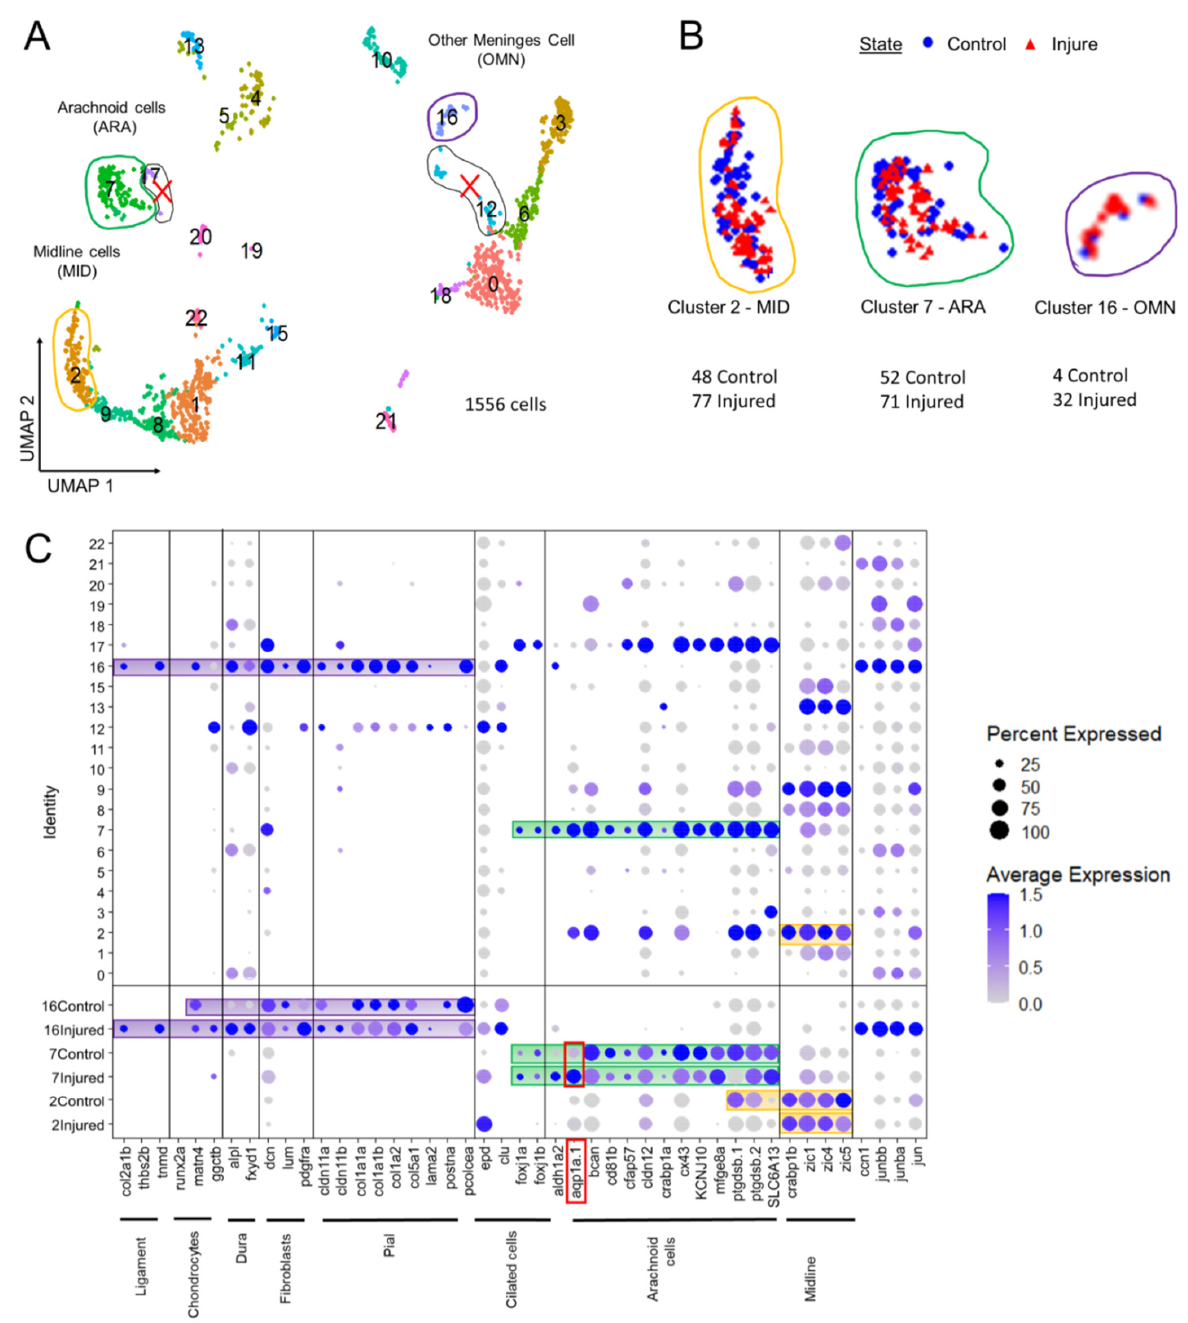
Figure 5. Analysis of scRNAseq data highlight cell heterogeneity of GFP cells from dissected tectum of PDGFR β -gal4;UAS: EGFP in 21 dpf injured fish and 21 dpf control fish. ( A ). Uniform manifold approximation and projection (UMAP) showing cell populations from 21 dpf control and injured fish. The projection was computed from the twenty first principal component analyses of gene expressions. Each point represents a single cell with a colour indicating its membership to a cluster. ( B ). UMAP of injured and control cells colored according to their sample types (blue circle for control fish and red triangle for injured fish). Approximately equal numbers of cells of each origin was observed in most clusters. This avoided batch effect. ( C ). Cluster analysis of characteristic DEGs from different cell populations including arachnoid cells (ARA) found in cluster 7, midline-like cells (MID) found in cluster 2 and other meninx cells (OMN) found in cluster 16. Cluster 17 et 12 contained DEGs similar to clusters 2, 7, 16 but these clusters were discarded from our analysis due to their small size and